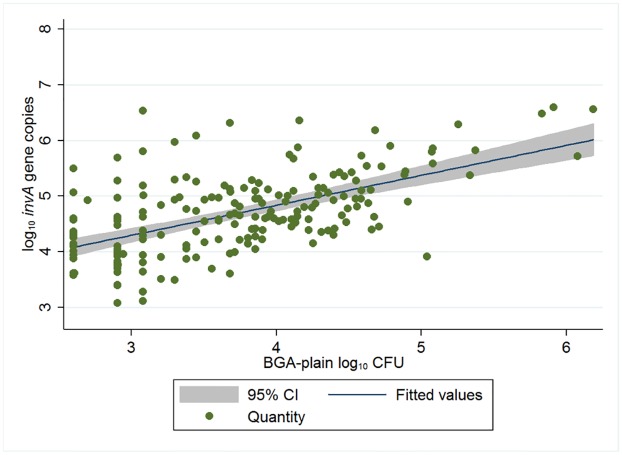
Linear prediction line and scatter plot of quantities of log10
invA genes via qPCR and log10 CFU on BGA-plain agar.Only with samples quantified using both methods (n = 190). The R2 was 0.43, the coefficient was 0.54 and the intercept was 0.61.